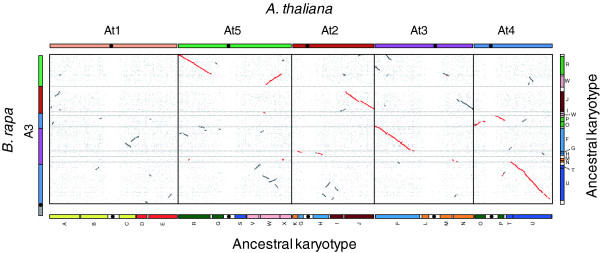
Synteny between B. rapa chromosome A3 and the A. thaliana genome. Chromosome correspondence between the genomes is represented by a dot-plot. Each dot represents a reciprocal best BLASTP match between gene pairs at an E value cutoff of < E-20. Red dots show regions of synteny with more than 50% gene conservation as identified by DiagHunter. Color bars on the upper and left margins of the dot plot indicate individual chromosomes of A. thaliana and B. rapa, respectively, demonstrating corresponding similarity. Black dots on the chromosomes are centromeres. Color bars on the bottom and right margins of the dot plot show ancestral karyotype genome building blocks mapped on the reduced karyotypes of A. thaliana and B. rapa, respectively. Bars of the same color are putative homologous counterparts.